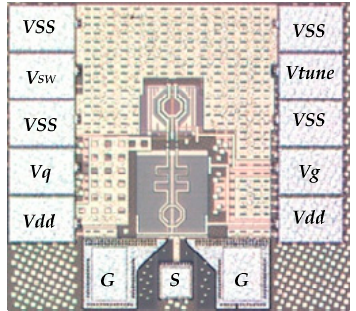
Figure 11. The microphotograph of the proposed VCO.